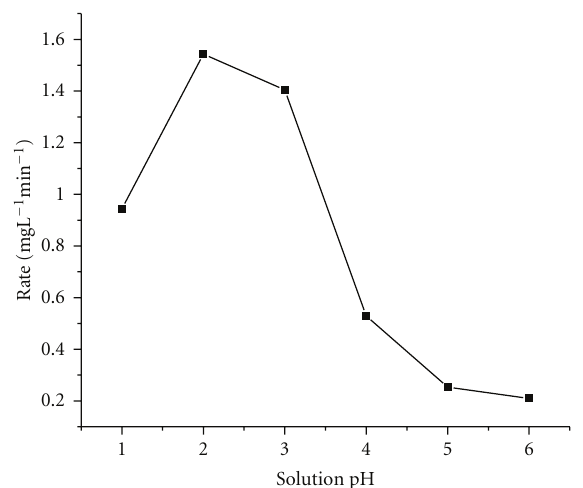
Figure 10: The e ff ect of pH on the degradation of dichlorvos by Mg 2+ -doped TiO 2 . Catalyst dosage = 0.10g, [DDVP] = 150 ppm.